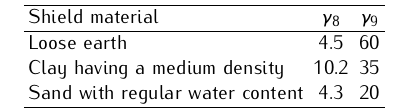
and γ for typical 8 9